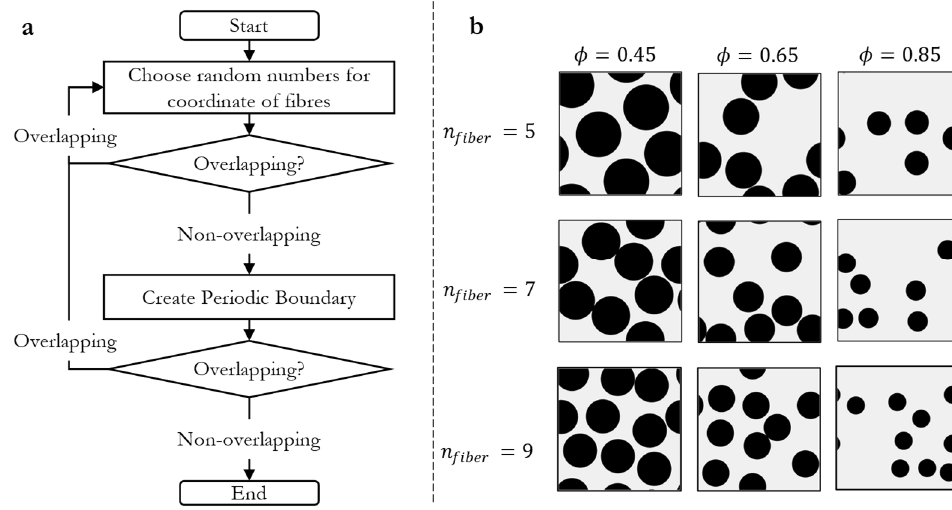
Figure 3. ( a ) Schematic process diagram of the generation of RVEs. ( b ) Exemplary RVEs with different porosities and fiber numbers. porosities and fiber